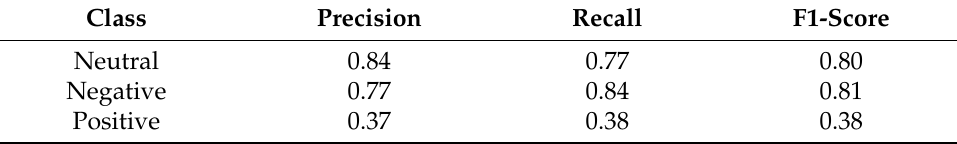
Table A4. Multilayer Perceptron evaluation.